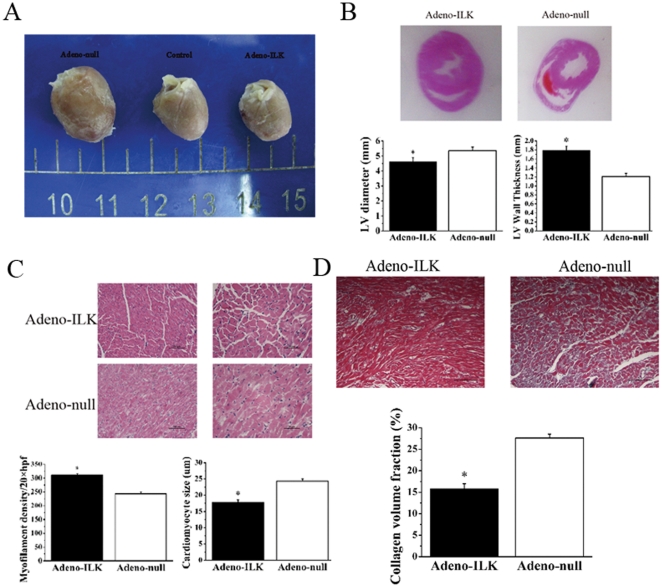
ILK gene therapy prevents left ventricular dilation, remodeling and interstitial fibrosis in doxorubicin-induced heart failure.A, Specimens showing effect of ILK treatment on heart size and shape following doxorubicin. B, Hematoxylin-eosin staining of myocardial sections 4 weeks after adeno-ILK or adeno-null treatment, with analysis of cardiac remodeling by quantification of left ventricular (LV) diameter and wall thickness. n = 6 per group. C, Myofilament density and cardiomyocyte size in adeno-ILK and adeno-null groups. n = 6 per group. Scale bars: 100 µm (left panels, 200×), 50 µm (right panels, 400×). D, Masson's trichrome staining showing infiltration by inflammatory cells and myocardial fibrosis in adeno-ILK and adeno-null animals. n = 6 per group. Scale bars: 5 mm. * P<0.05 vs. adeno-null.